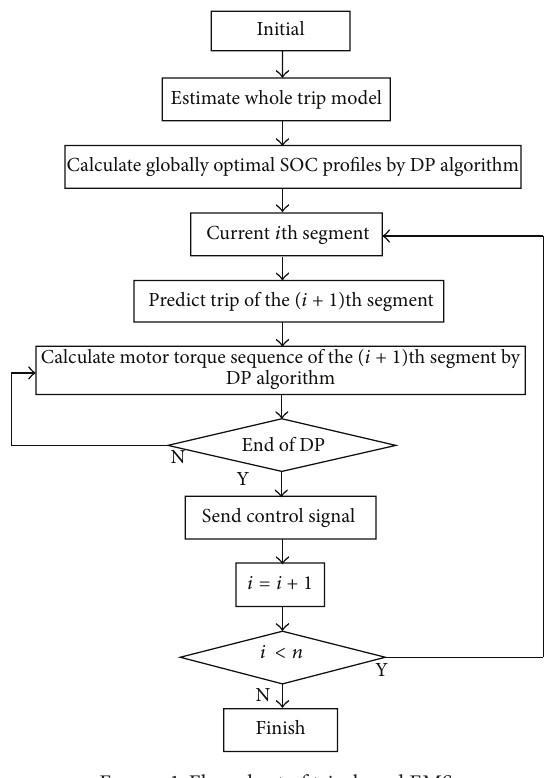
Figure 1: Flow chart of trip-based